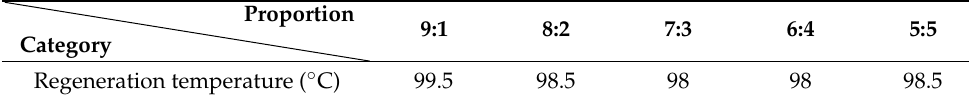
Table 5. Regeneration temperature comparison of AEP-DPA composite system.